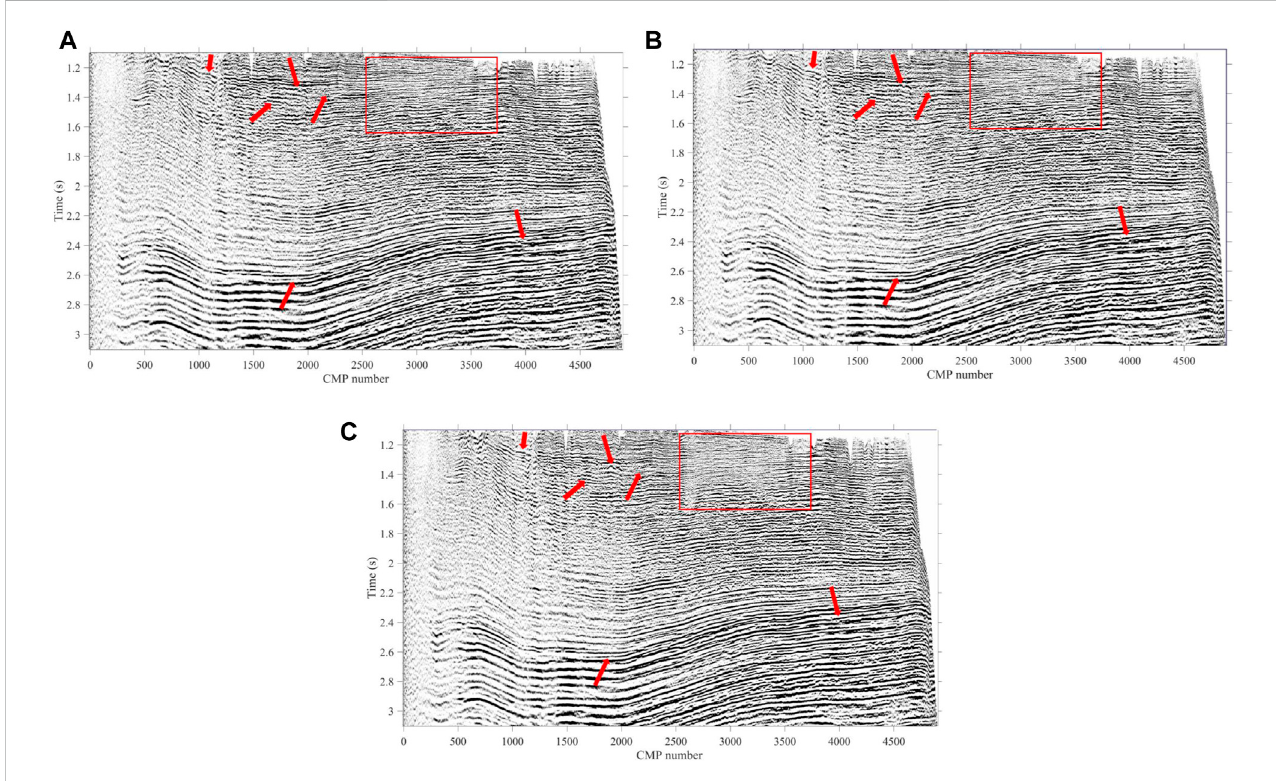
FIGURE 17 Local enlarged stacking pro fi les of (A) manual, (B) method proposed, and (C)